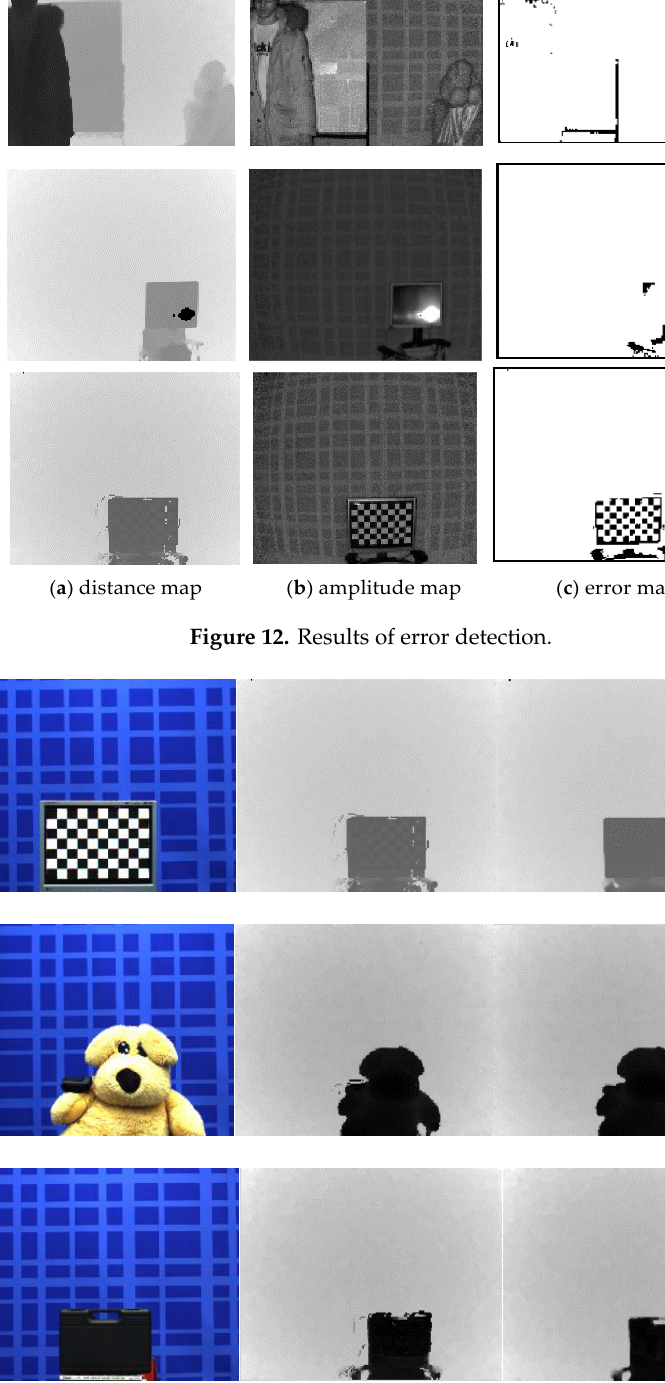
Figure 13. Results of the error correction method using different integration times. ( a ) Color image, ( b ) distance map (ToF 2), and ( c ) corrected distance map.